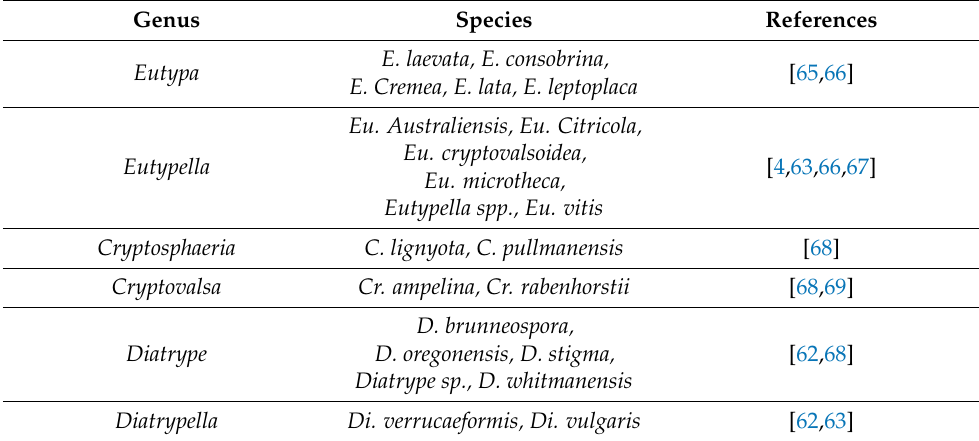
Table 2. Species of Diatrypaceae involved in Eutypa